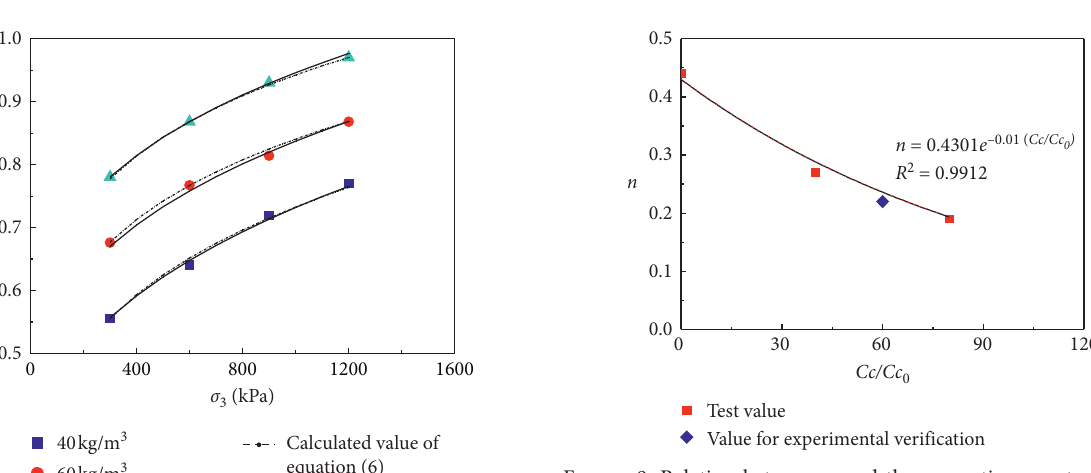
Figure 9: Relation between n and the cementing agent